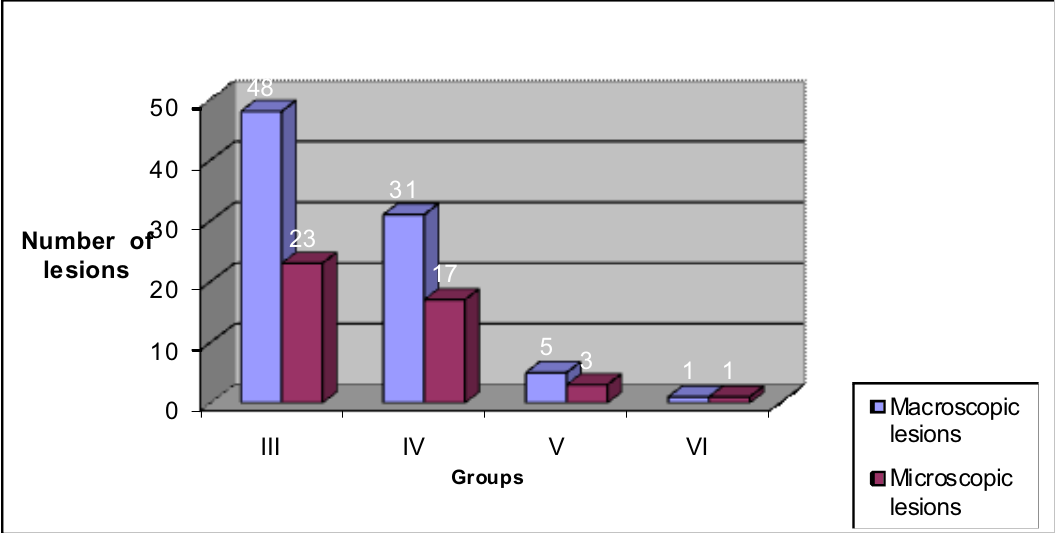
FIGURE 1 - Number of lesions in the